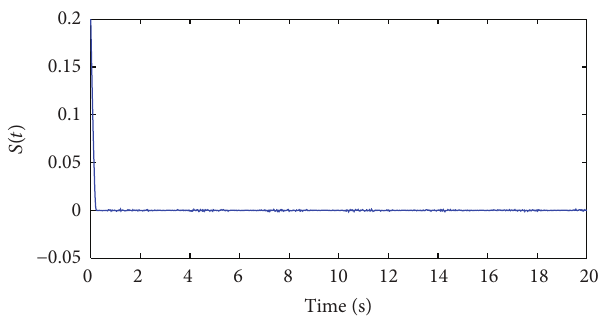
Figure 5: Time responses of switching surface 𝑆(𝑡) under effects of